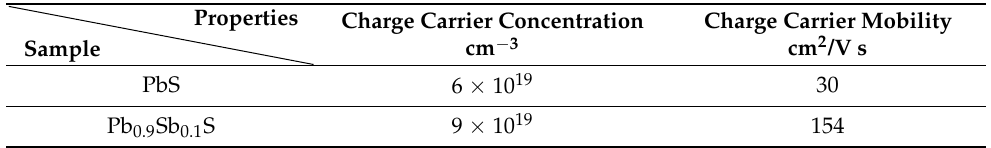
Table 1. Charge carrier concentration and mobility of PbS and Pb 0.9 S 0.1 bS, according to hall measurements.